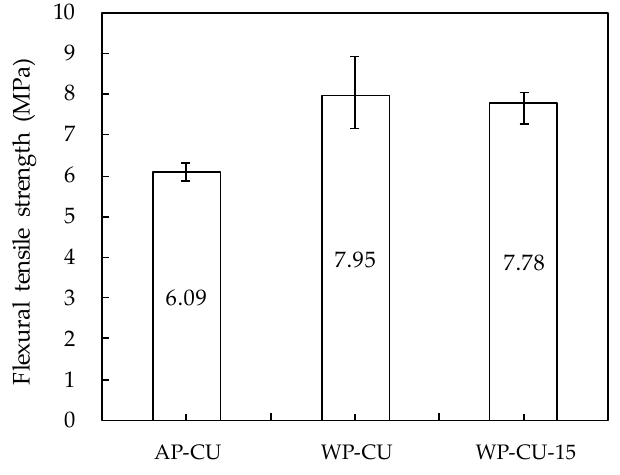
Figure 16. Flexural tensile strength.